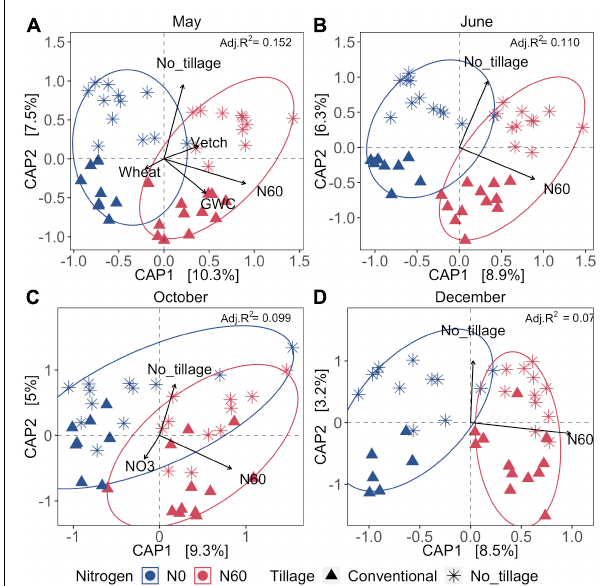
FIGURE 3 | Canonical analysis of principal coordinates (CAP) across four seasons under tillage, fertilization, and cover cropping treatment. (A–D) The samples collected in May, June, October, and December, respectively. Colors represent the fertilization (0 or 67 kg ha − 1 or 60 lb acre − 1 ), and shapes represent the tillage treatment (no-till or intensive tillage). The significant environmental indicators are shown as arrows ( p < 0.05). The Bray–Curtis dissimilarities were calculated to estimate the differences among samples. GWC was the gravimetric water content. NO3 was nitrate-N in ppm. N60 represented inorganic N fertilization. Vetch and wheat were the two cover cropping types. Adjusted R -square values indicate the total percentage explanation of variation by significant factors (shown as arrows) at each sampling date, which were shown on the right corner of each plot.